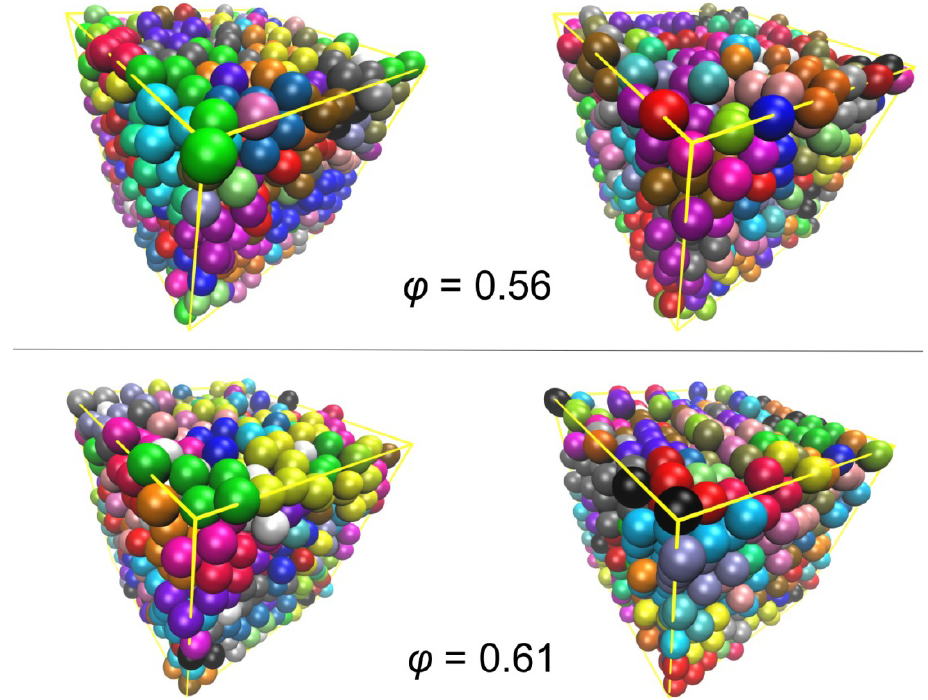
Figure 5. System configurations of the hard-sphere chain packing ( N = 12) as obtained from MC simulations at packing densities of φ = 0.56 (upper panels) and φ = 0.61 (lower panels). Snapshots at the beginning and at the end of the simulation appear in the left and right panels, respectively. Spheres are color-coded according to the parent chain molecule. Image created with the VMD software